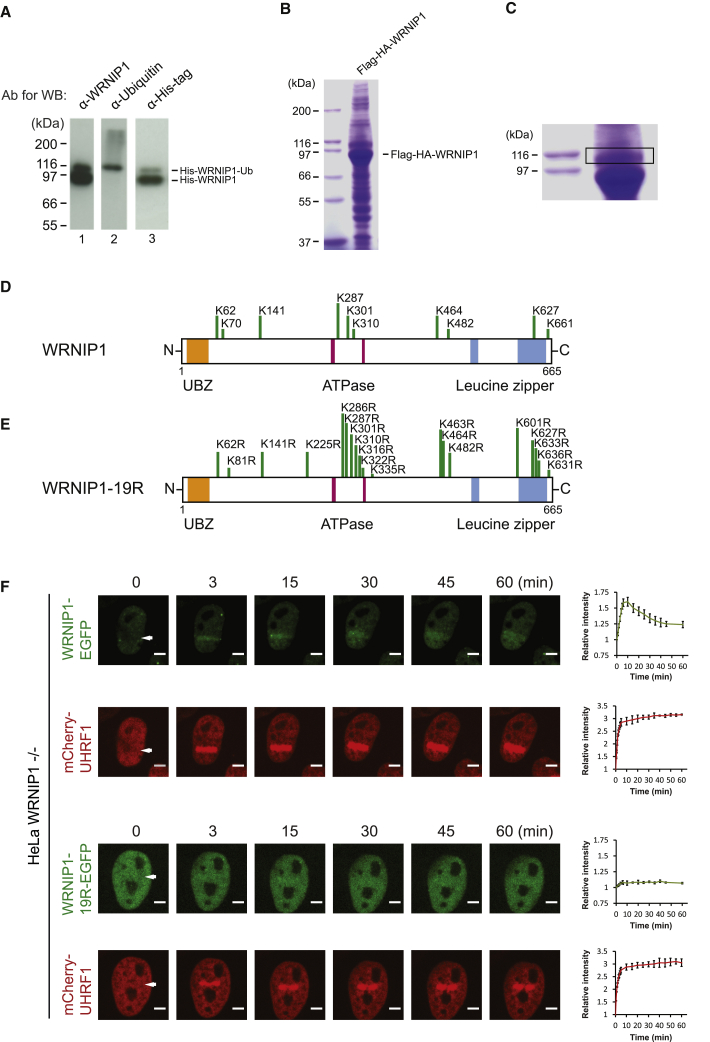
Ubiquitination of WRNIP1 Is Required for Recruitment to ICLs(A) His-tagged WRNIP1 was purified from Sf9 insect cells and analyzed by immunoblot analysis using the antibodies indicated.(B) Coomassie blue staining of Flag-HA-WRNIP1 purified together with associated proteins from HeLa S3 cells.(C) Magnified view of part of (B), showing the area of the gel that was excised for mass spectrometry analysis.(D) Schematic showing locations of amino acids in WRNIP1 that were found to be modified by ubiquitin.(E) Schematic showing locations of lysines in WRNIP1 that were mutated into arginines in WRNIP1-19R.(F) Live-cell imaging of HeLa-WRNIP1-EGFP and HeLa-WRNIP1-19R-EGFP cells. Cells were treated with TMP, microirradiated at the indicated areas (white arrows), and followed over time. Quantification shows relative intensities of the irradiated areas. Data represent 2 independent experiments (n = 2), and 10 cells were quantified for each chart (mean ± SEM). Scale bar, 10 μm.